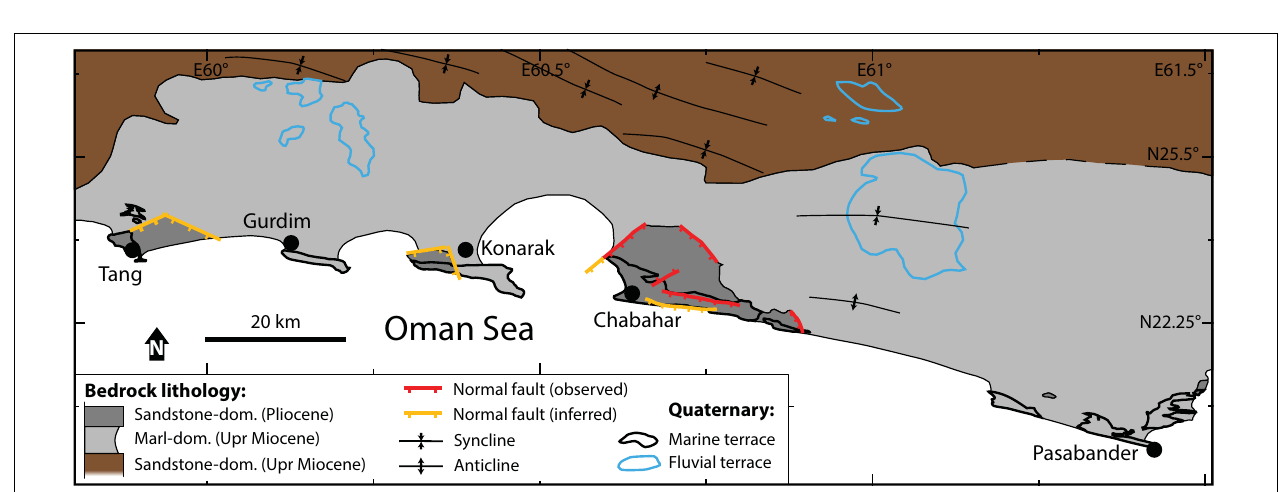
FIGURE 2 | Simplified bedrock lithology map of the Chabahar region, emphasizing location of marl or sandstone dominated lithologies. Except for the Chabahar headland, the Pliocene age of sandstone-dominated outcrops are inferred.